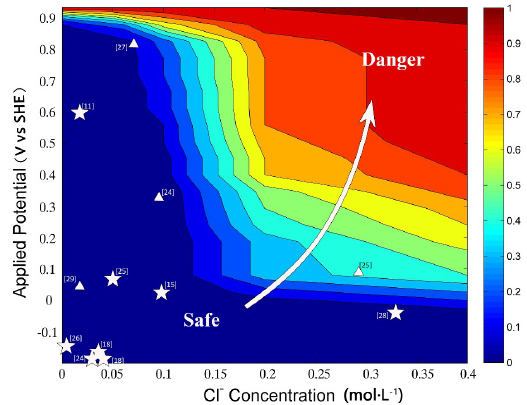
Figure 10. The top viewport of variation of the pitting probability with the potential and Cl − concentration at pH 12.5 (the data from other literatures: ☆ : the chloride in the security zone on the reinforcing steel at pH 12.5. △ : the chloride in the pitting corrosion of reinforcing steel at pH 12.5. [11,15,18,24–29]: the corresponding document with the data.). The top view direction is on the axis of pitting probability, and the color scale indicates the value of the pitting probability.